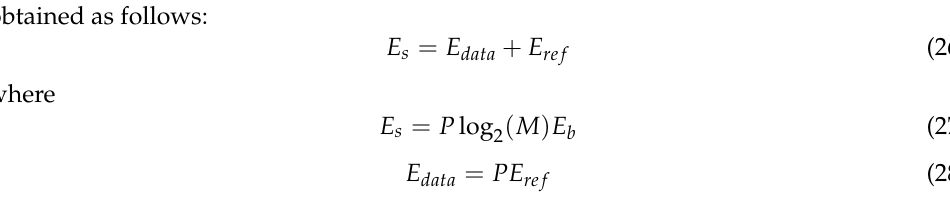
Figure 8. BER performance of the MC-MDCSK-MCS with different N c over the AWGN